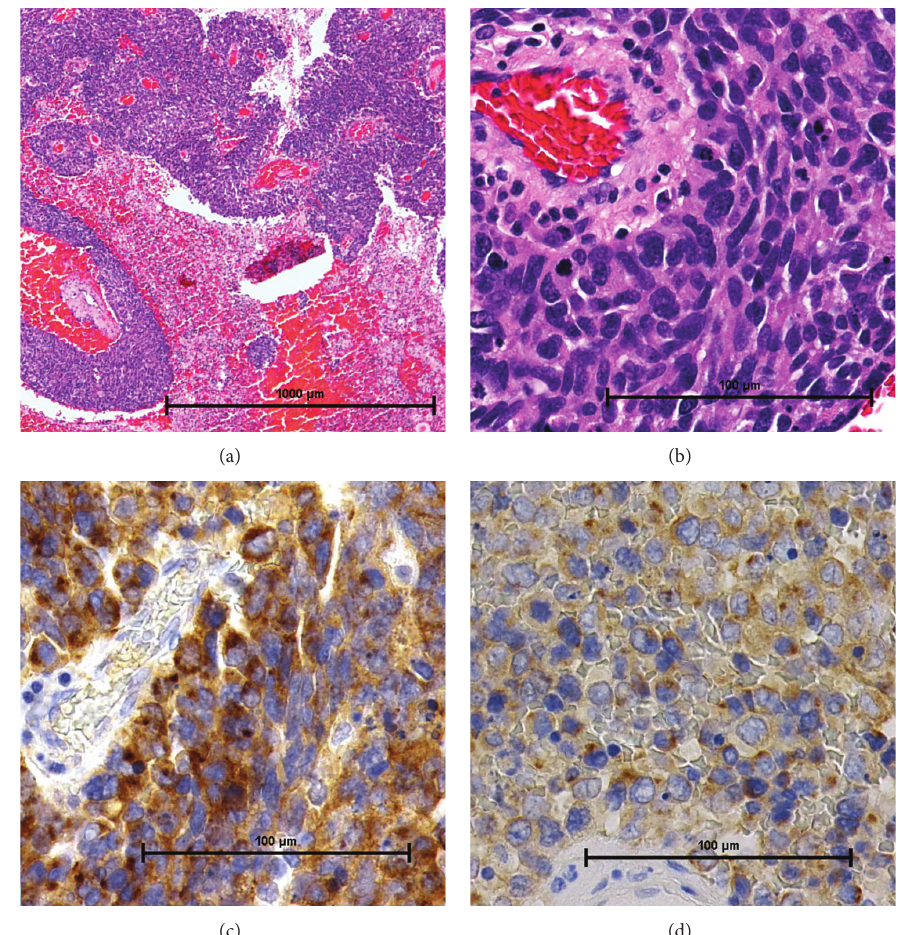
Figure 4: (a) Photomicrograph showing the tumor filled with necrosis. (H&E stain, original magnification × 20. Bar: 1000 𝜇 m.) MIB-1 index, 37%. (b) Photomicrograph showed a large number of cells with nuclear atypia around the vessels. (H&E stain, original magnification × 100. Bar: 100 𝜇 m.) (c) Chromogranin stain is positive. (Original magnification × 200. Bar: 100 𝜇 m.) (d) Synaptophysin stain is positive. (Original magnification × 200. Bar: 100 𝜇